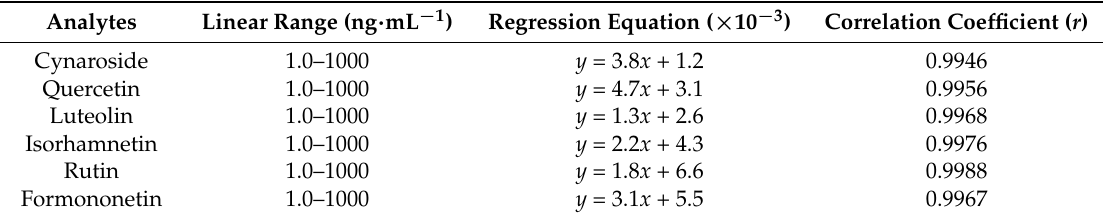
Table 1. Linear ranges, regression equations and correlation coefficients of multi-components in rat plasma biosamples.